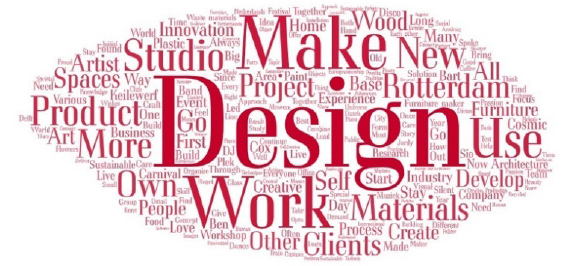
Figure 6. Word cloud derived from M4H company taglines.